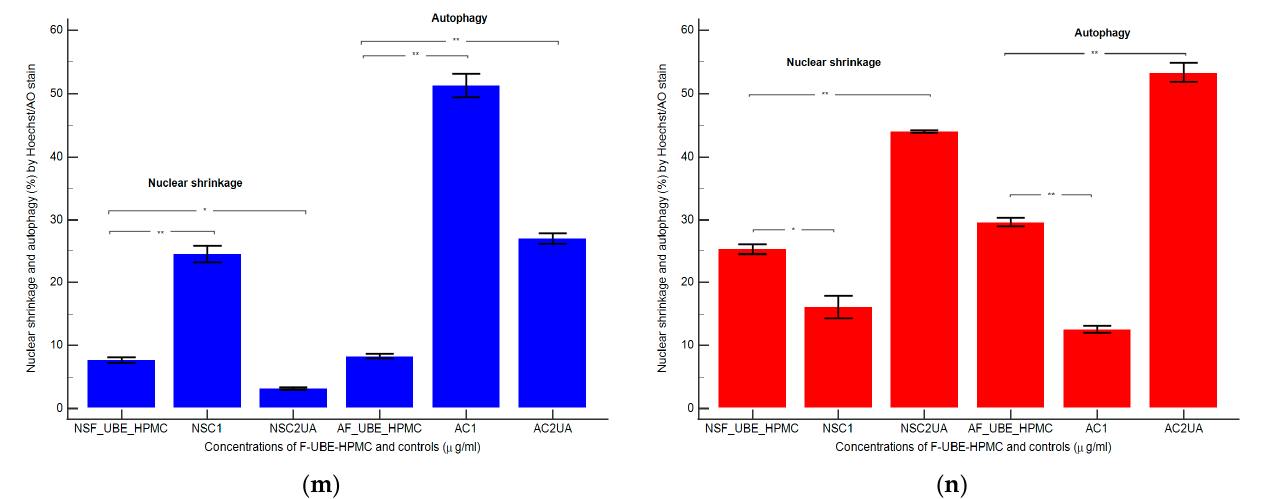
Figure 7. Nuclear shrinkage models ( a – f ) in normal blood cells ( a – c ) and CLS-354 tumor cells ( d – f ), after 24 h treatment with F-UBE-HPMC. Hoechst patterns of F-UBE-HPMC ( a , d ); 1% DMSO negative control ( b , e ); 125 µg/mL UA-positive control ( c , f ); Lysosomal Activity ( g-l ) in normal blood cells ( g – i ) and CLS-354 tumor cells ( j – l ). Acridine orange patterns of F-UBE-HPMC ( g , j ); 1% DMSO negative control ( h , k ); 125 µg/mL UA-positive control ( i , l ); Statistical analysis of nuclear shrinkage and lysosomal activity ( m,n ) in normal blood cells ( m ) and CLS-354 tumor cells ( n ). * p < 0.05 and ** p ≤ 0.01 reveal significant statistical differences between controls and F-UBE-HPMC made by paired samples t -test; NS—nuclear shrinkage; A—autophagy; F-UBE-HPMC—mucoadhesive oral patches loaded with U. barbata (L.) dry ethanol extract; C1—negative control with 1% dimethyl sulfoxide (DMSO); C2UA—positive control with 125 µg/mL usnic acid (UA).